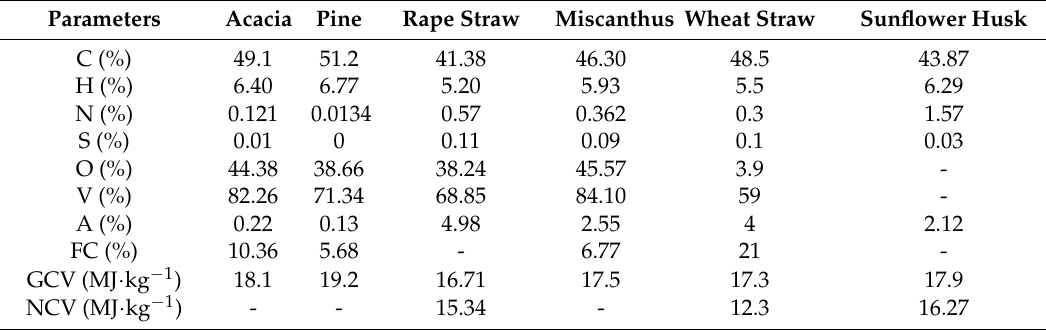
Table 4. Comparison of physicochemical properties of selected biomass species [35–38].